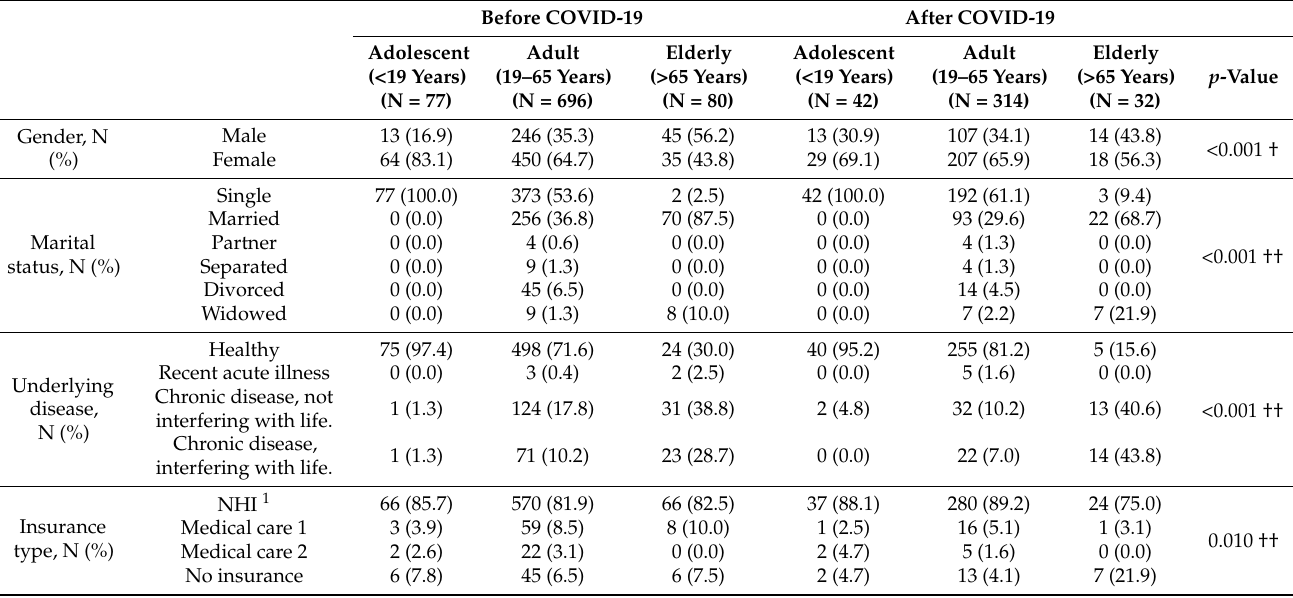
Table 1. Baseline characteristics before and after